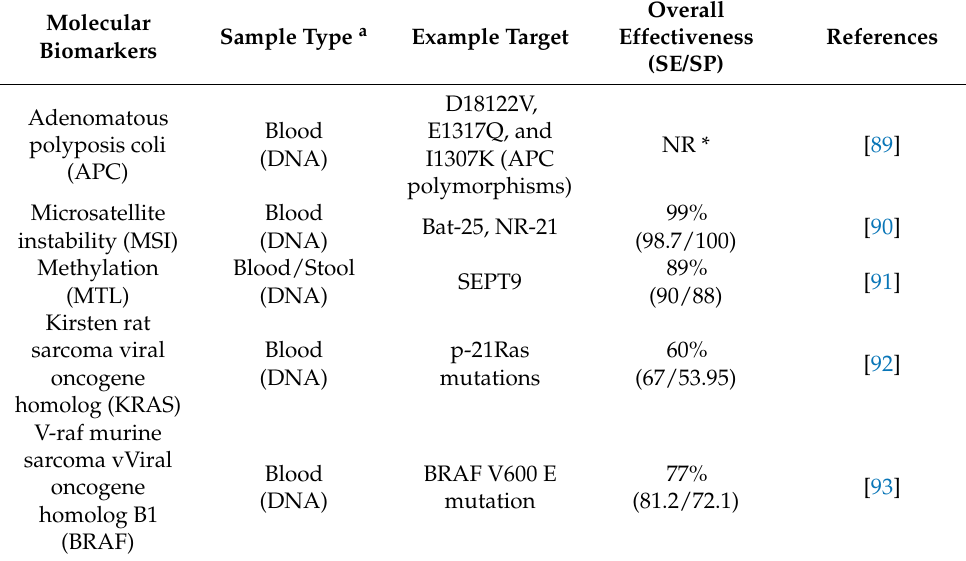
Table 2. Most used CRC molecular biomarkers clinically used for diagnosis and prognosis.